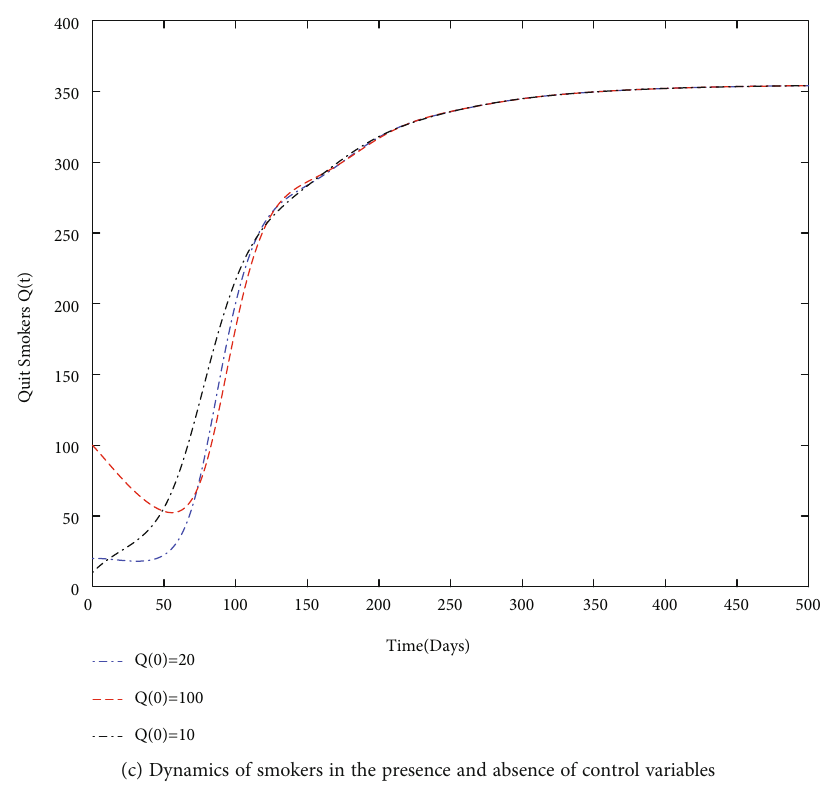
Figure 4: The plot presents a comparison of solution curves both with and without